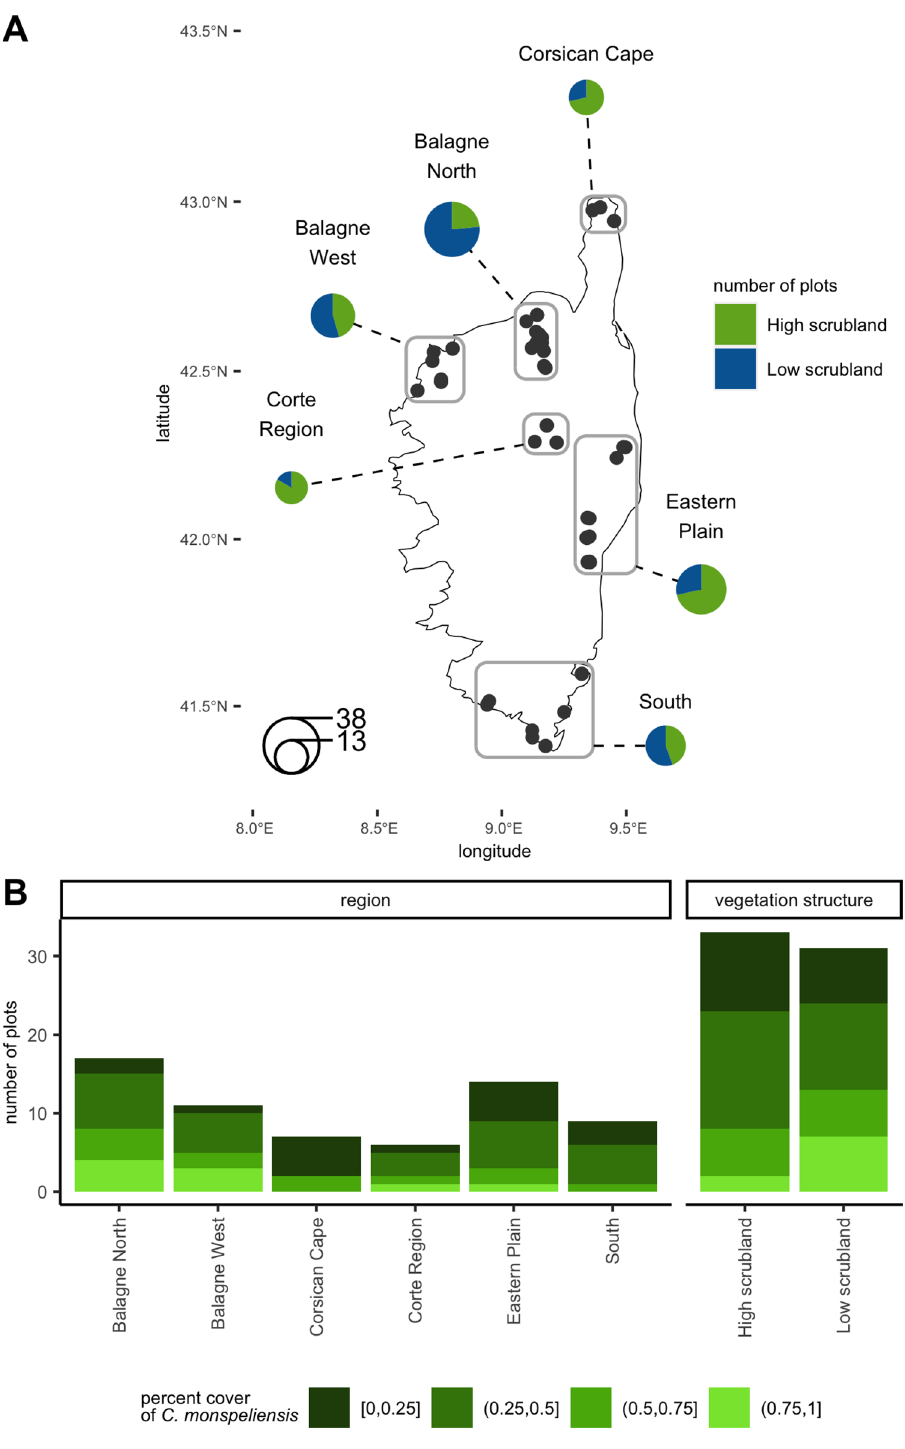
Figure 1. Sampling scheme. ( A ) Distribution of plots and vegetation structure. The size of the circles is proportional to the number of plots. ( B ) Percent cover of C. monspeliensis in each region and for each type of vegetation structure: high scrubland (tree cover exceeding 25%) and low scrubland (shrub and herbaceous formations with tree cover below